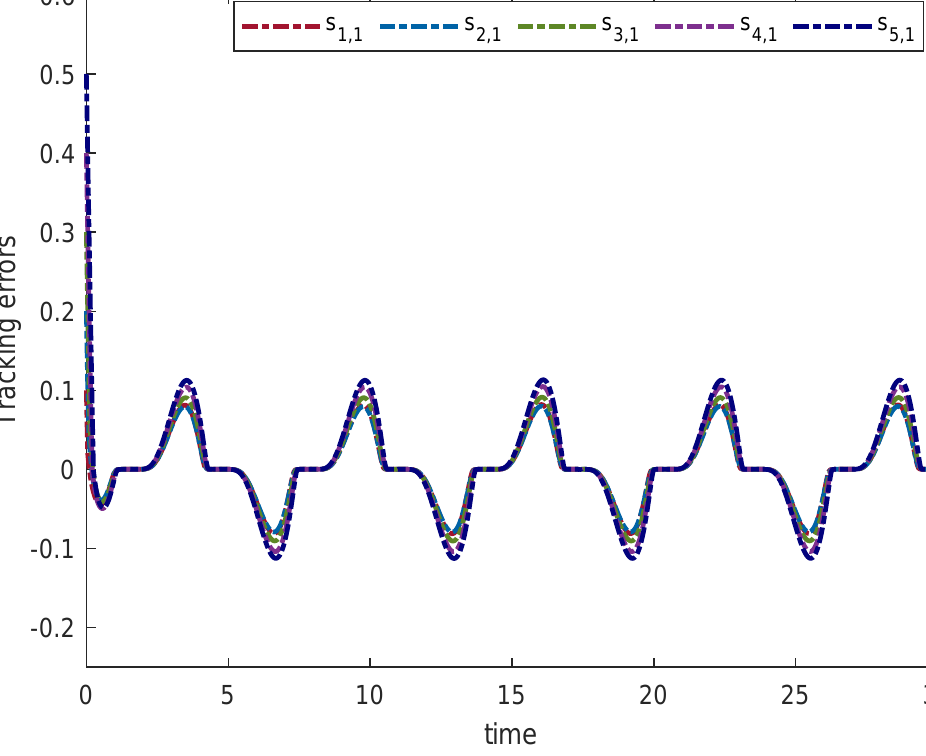
Figure 18. The trajectories of error s i ,1 ( i = 1, · · · ,5 ) based on the finite-time distributed